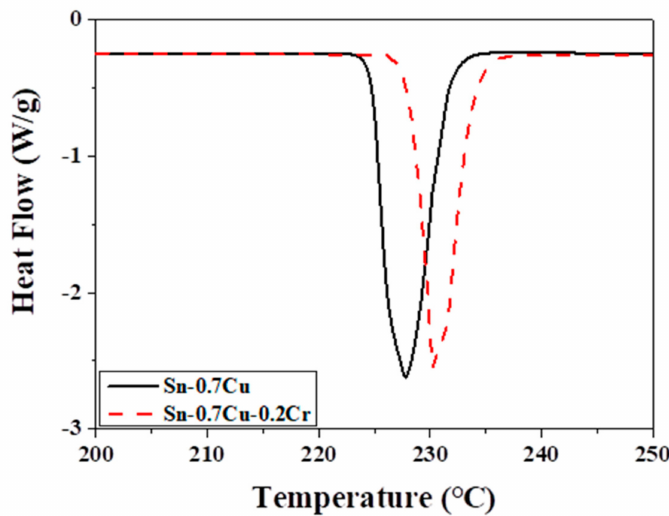
Figure 3. DSC curve of Sn-0.7Cu and Sn-Cu-0.2Cr solders.